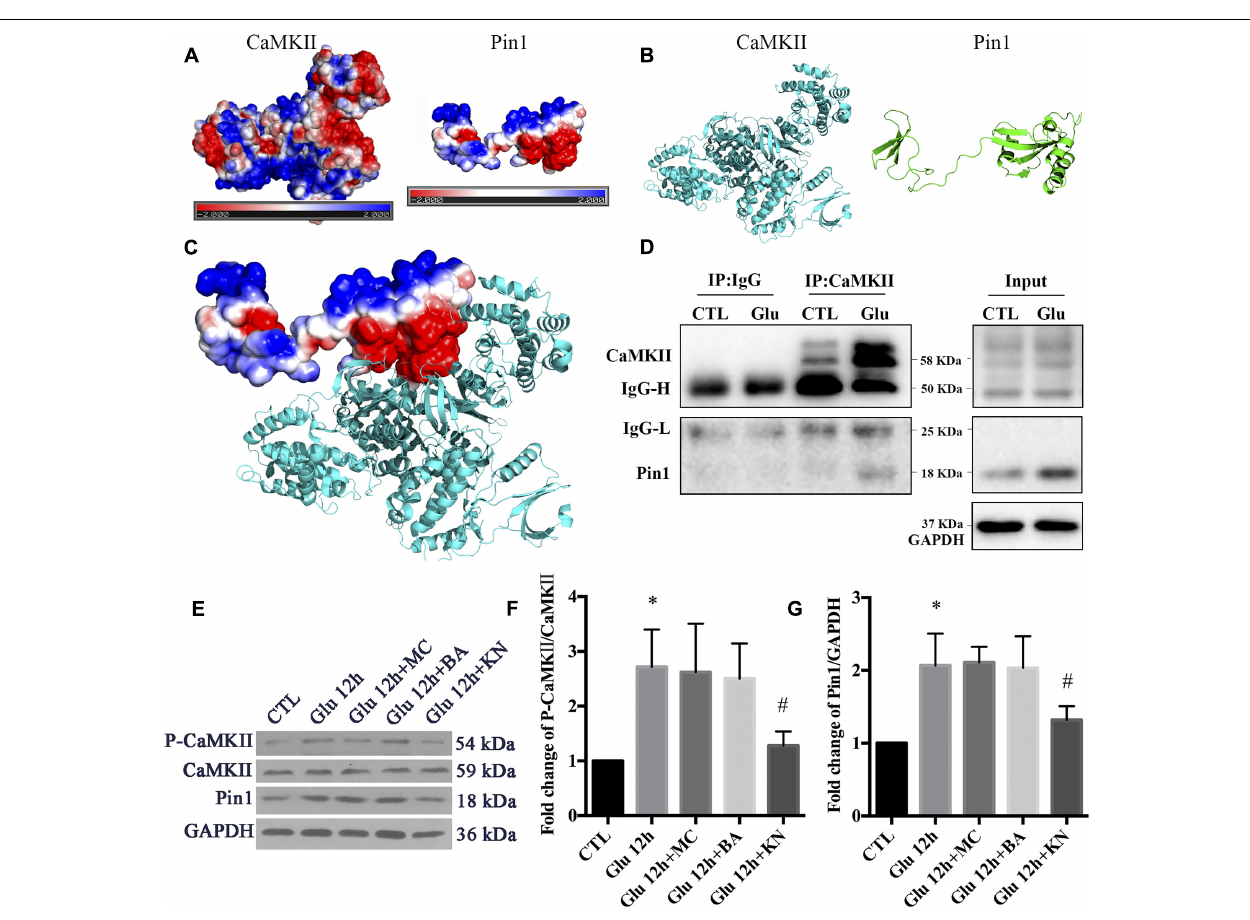
FIGURE 5 | The regulatory role of CaMKII in Pin1 activity. (A) Three dimensional structure of proteins by homologous modeling (Swiss Model). (B) Protein surface electrostatic potential energy are calculated by APBS (Figures are produced by using PyMOL). (C) The initial binding mode is constructed by manually binding areas with opposite electrostatic potential of two proteins and then the protein complex is energy minimized using molecular dynamics software NAMD v2.12. (D) IP assay of CaMKII and Pin1. Pin1 was pull-down with CaMKII antibody suggested by a 18 KDa band as observed. (E) Western blot of CaMKII, p-CaMKII, and Pin1 expression after Glu, MC, BA, and KN treatment. (F) The statistical analysis of p-CaMKII/CaMKII expression. (G) The statistical analysis of Pin1 expression. MC, BA, and KN were used 30 min before glutamate treatment at a concentration of 50, 10, and 10 µ M, respectively. N = 3 cultures. Data were analyzed using one-way ANOVA. ∗ p < 0.05 vs. CTL group, # p < 0.05 vs. Glu